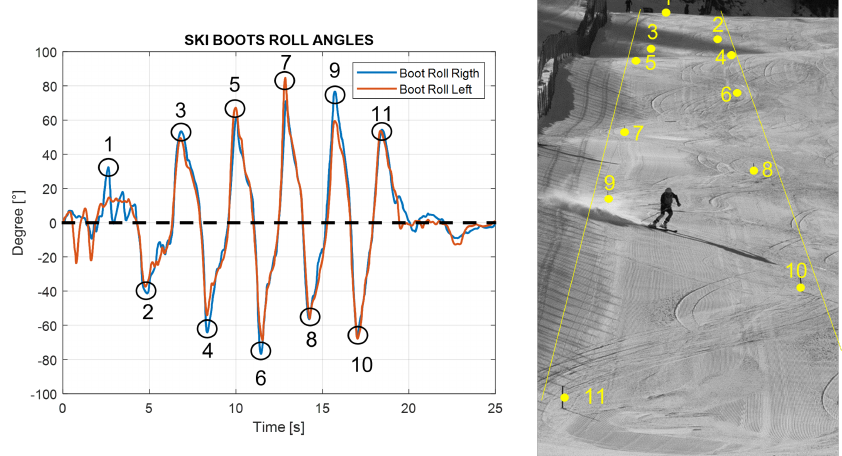
Figure 8. Number of turns in video and roll angle.